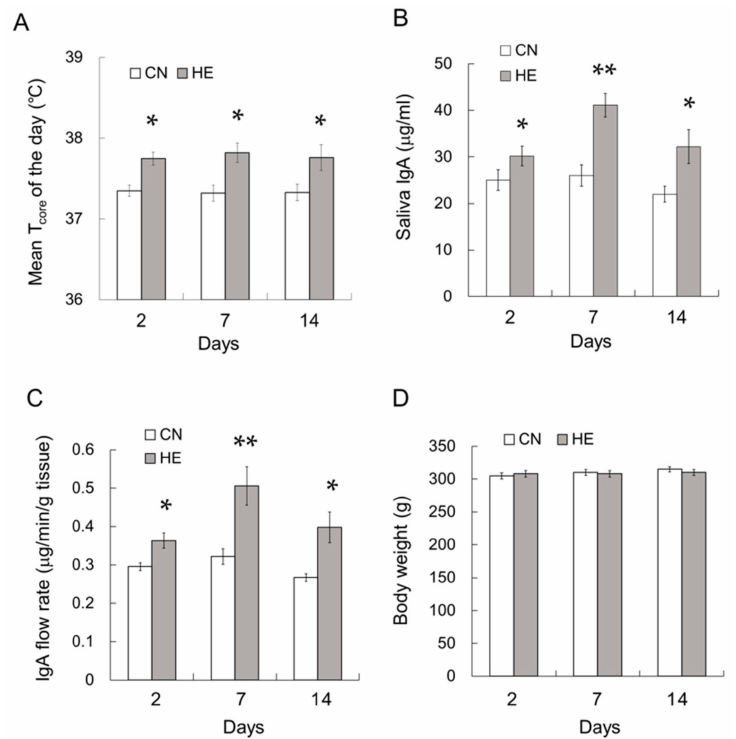
Figure 7. Time course analysis of the mean core body temperature (T core ), saliva IgA concentration, IgA flow rate, and pIgR expression in the submandibular glands (SMGs) of control (CN) and heat-exposed (HE) rats. ( A ) Mean T core of CN and HE rats during the heat exposure period. T core was measured at 2 nd , 7 th and 14 th day of heat exposure period. ( B ) Saliva IgA concentration. ( C ) Saliva IgA flow rate. The mean T core , IgA concentration and IgA flow rate were increased during the first 2 days of heat exposure and appeared to persist for at least 14 days. ( D ) Body weight of CN and HE rats. Values are presented as the mean ± SEM ( n = 4 in each group). * p < 0.05, ** p < 0.01, significant di ff erence between the CN and HE